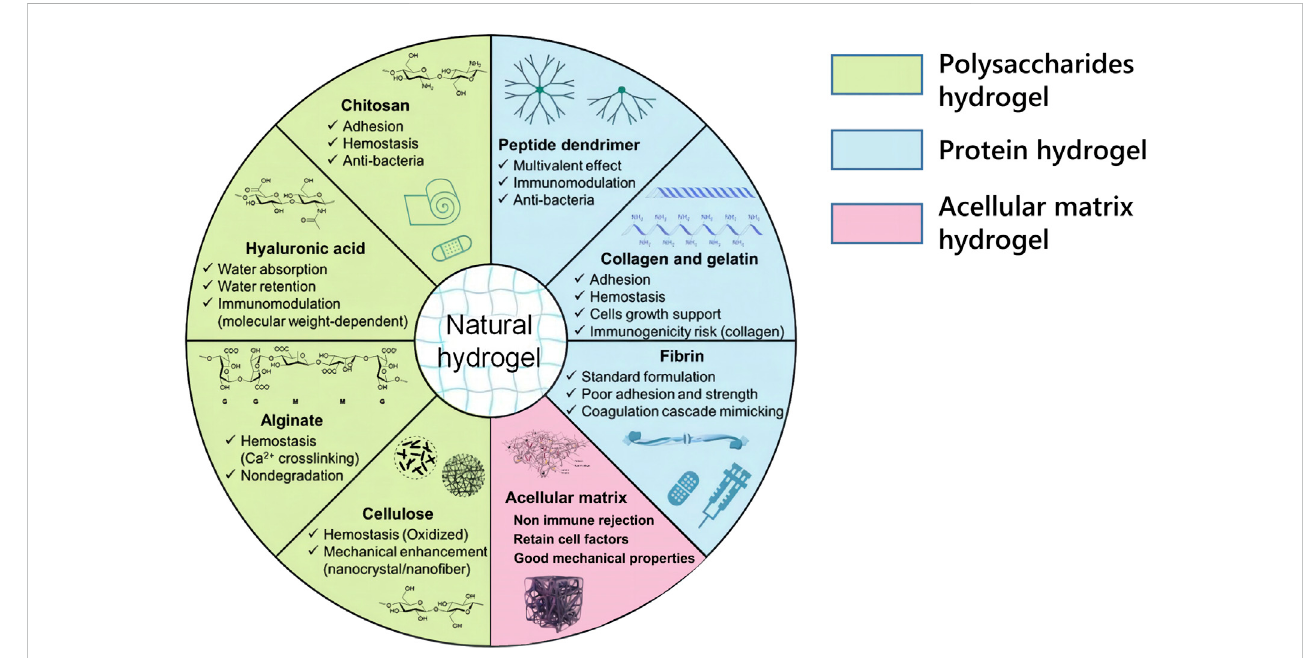
FIGURE 4 Schematic diagram of commonly used natural hydrogels and their biological